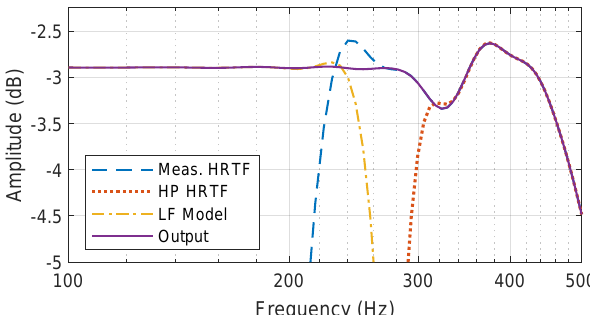
Figure 3. The 275 Hz crossover of a measured HRTF and individually generated low frequency